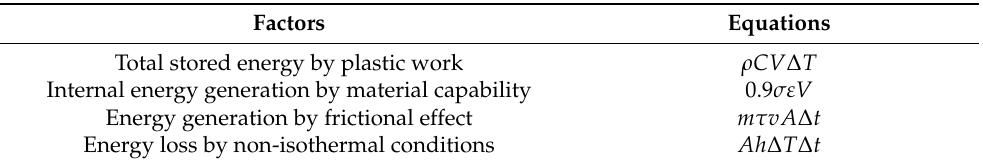
Table 1. Factors and their equations influencing the temperature increase of the sheet during differential speed rolling (based upon the energy-based state equation), reproduced from [74], with permission from Elsevier,